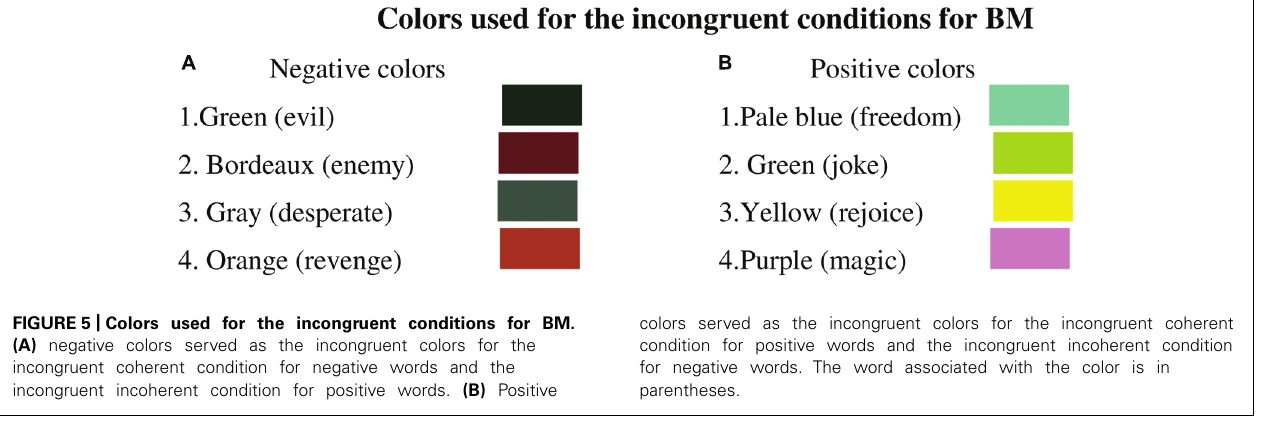
colors served as the incongruent colors for the incongruent coherent condition for positive words and the incongruent incoherent condition for negative words. The word associated with the color is in